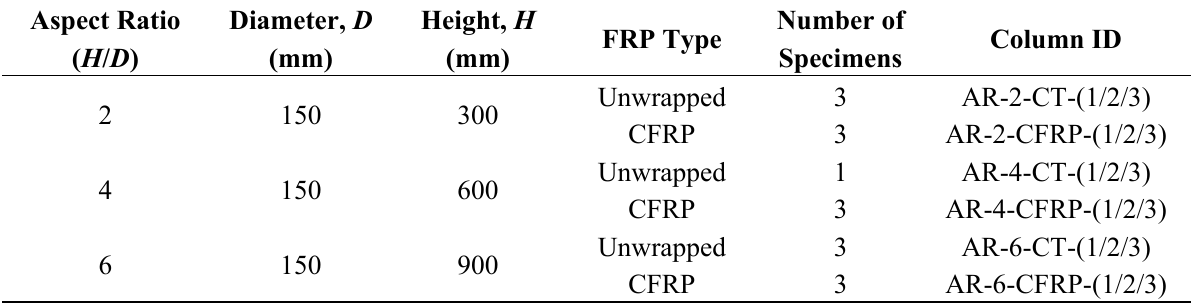
Table 3. Test matrix of the aspect ratio columns wrapped with CFRP sheets, along with their respective control specimens